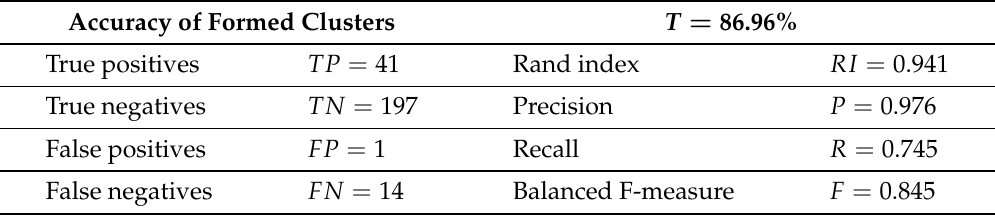
Table 4. Evaluation of clustering results obtained by IBC1 algorithm using CMU-MMAC